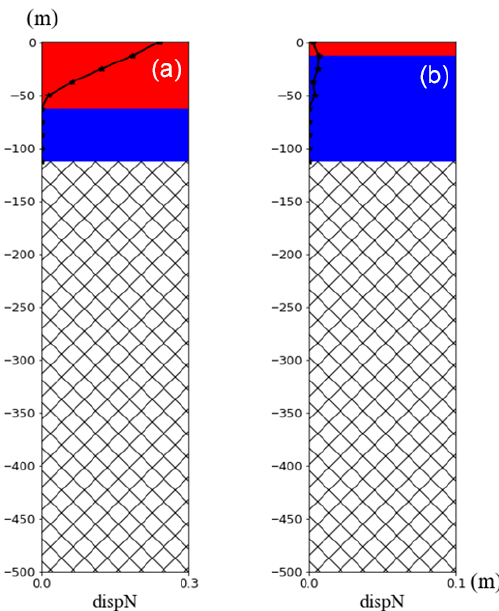
Figure 4. Results of the depth (active in red and inactive in blue) and horizontal displacement (black line) of rupture by IE model at the (a) 10th and (b) 20th time